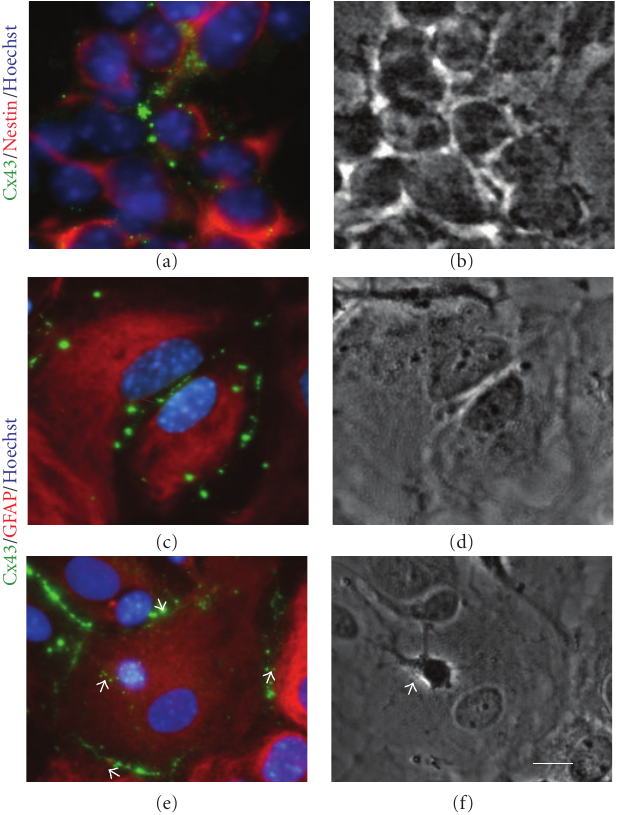
Figure 3: Cx43 expression in mouse cortical cells. (a) Immunocytochemistry showed that Cx43 (green) is expressed in Nestin- (red) positive cortical progenitors. (c) Similarly, abundant levels of Cx43 protein were detected at cell-cell boundaries in cortical astrocytes. (e) Only a limited amount of Cx43 was detected in immature neurons (arrow), whereas astrocytes maintained high degrees of Cx43 expression. (b), (d) and (f) are the corresponding phase contrast images of (a), (c) and (e), respectively. Nuclei were stained with Hoechst (blue). Scale bar: 10 μ